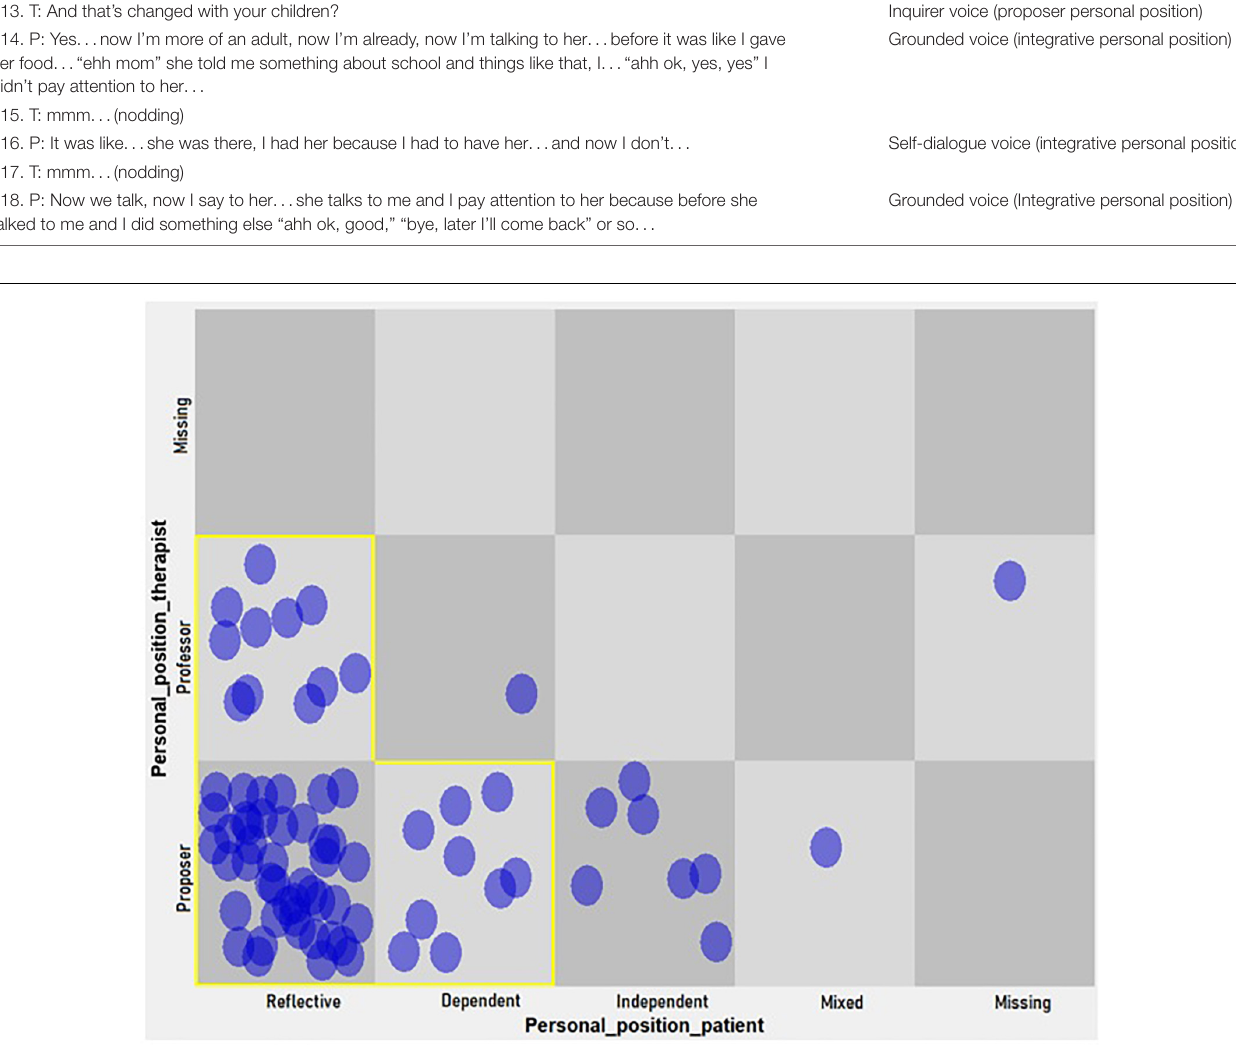
FIGURE 2 | Dynamic pattern in personal positions of the patient and her therapist (level 1, change